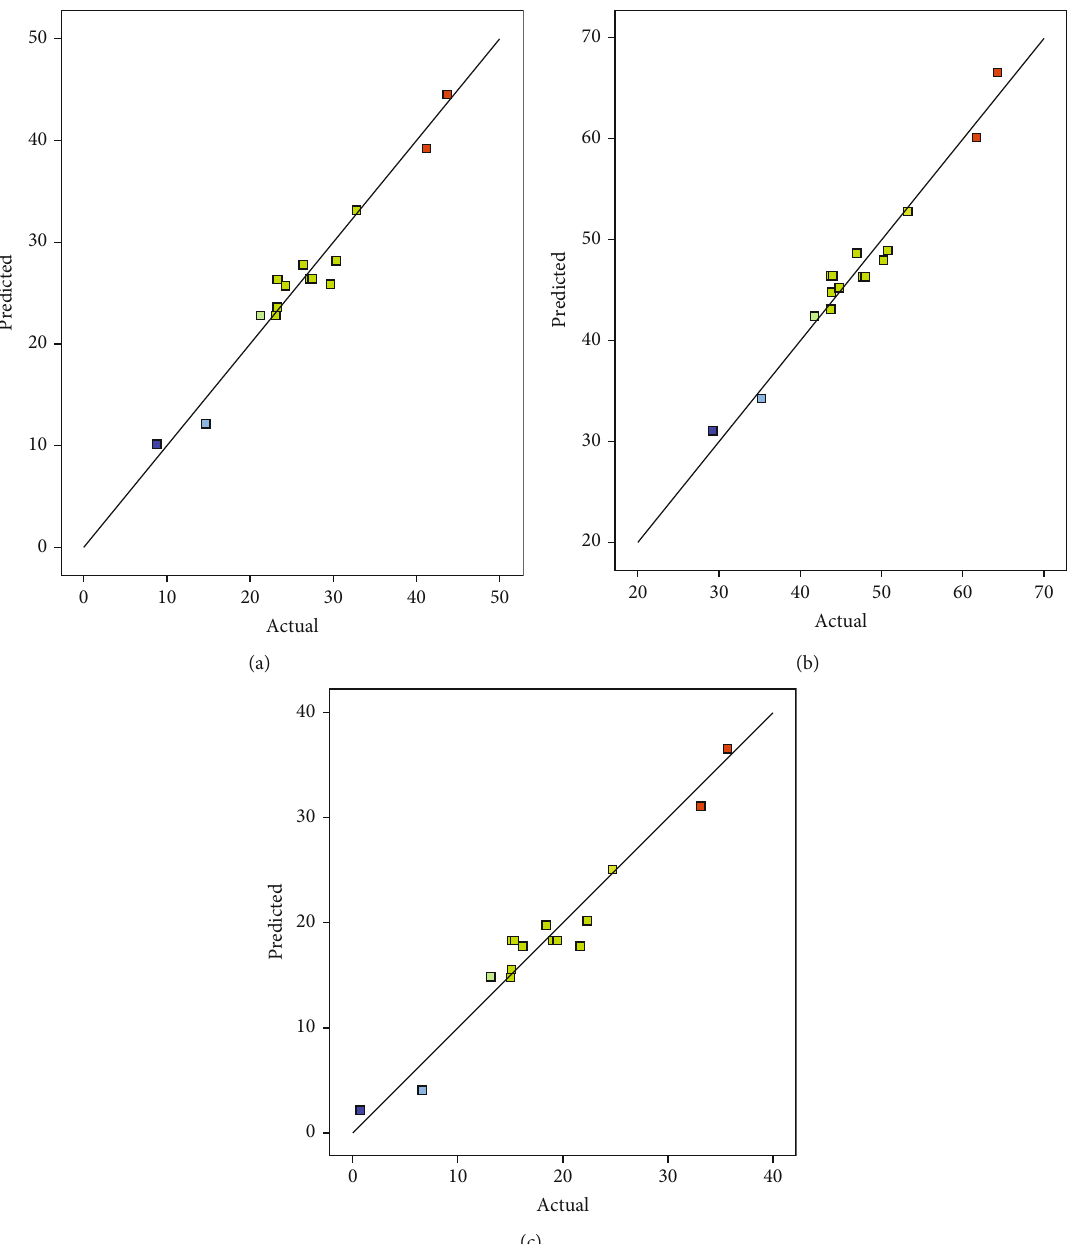
Figure 8: Prophesied vs. de fi nite value of (a) tension, (b) bending, and (c) impact behaviour of CGF- and nano-silica-based